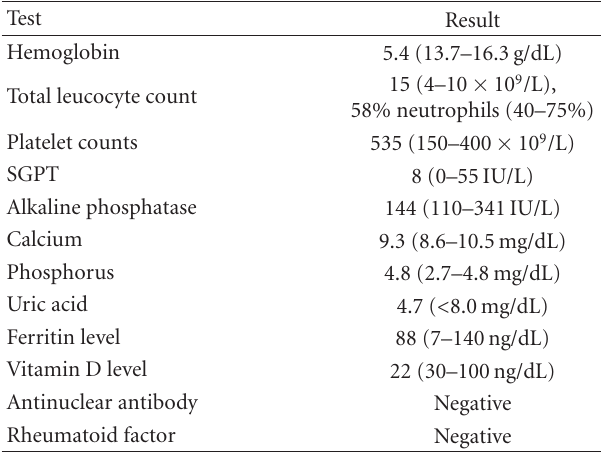
Table 1: Laboratory